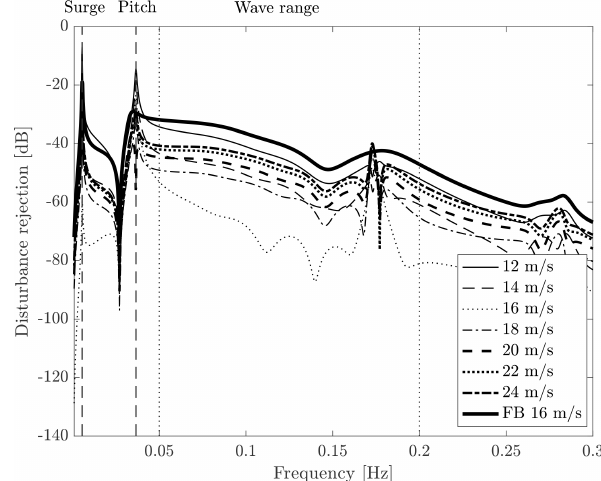
Figure 5. The sensitivity function of the feedback (FB) controller for onshore and offshore tuning and of the feedback–feedforward (FBFF) in 16m/s wind is compared to the typical PSD of wind and waves (magnitude has been rescaled to ease the comparison with sensitivity functions). The vertical dashed lines are the frequency of the platform surge and pitch modes; the dotted lines mark the bandwidth of the FB controller with onshore and offshore gains.